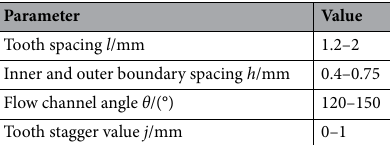
Table 1. The value ranges of structural